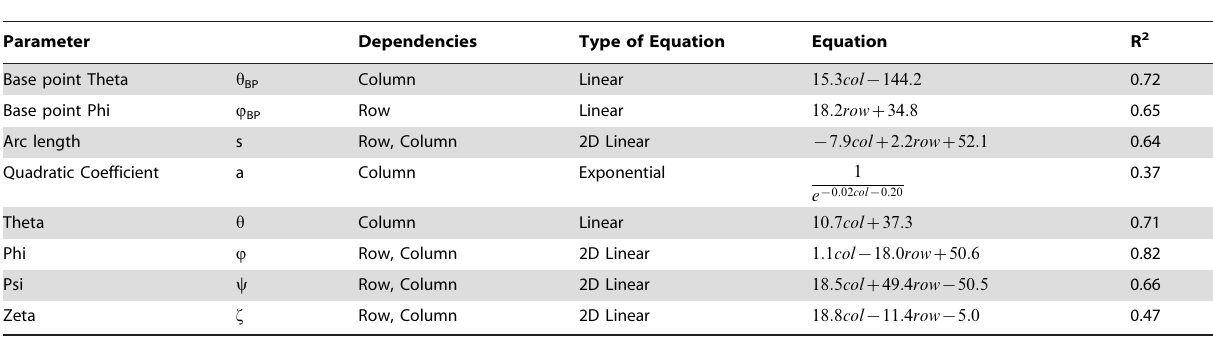
Table 3. Equations relating each whisker parameter to whisker